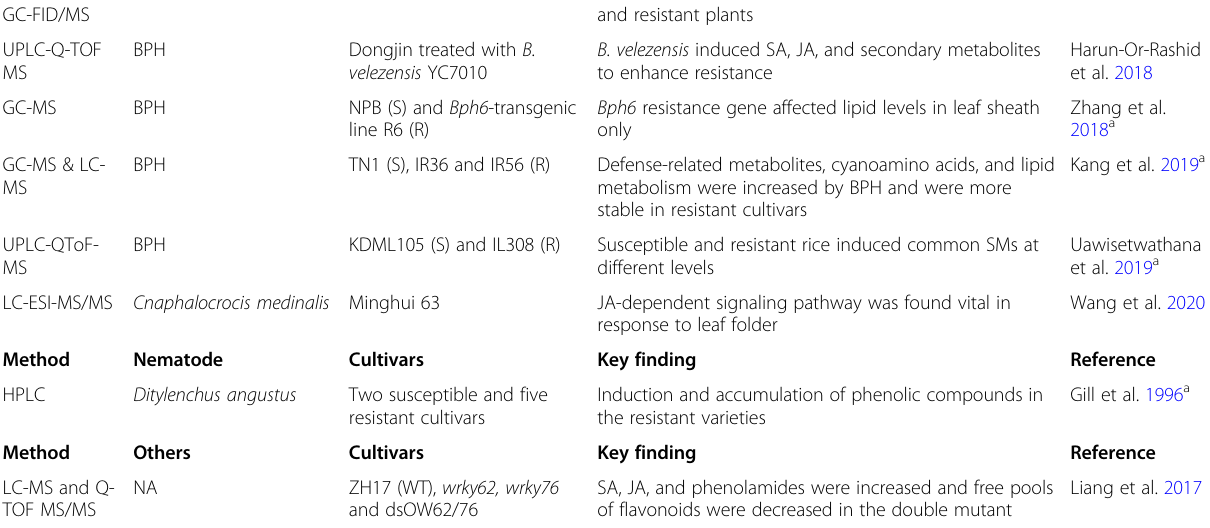
Table 2 Global metabolomics studies investigating biotic stress responses in rice